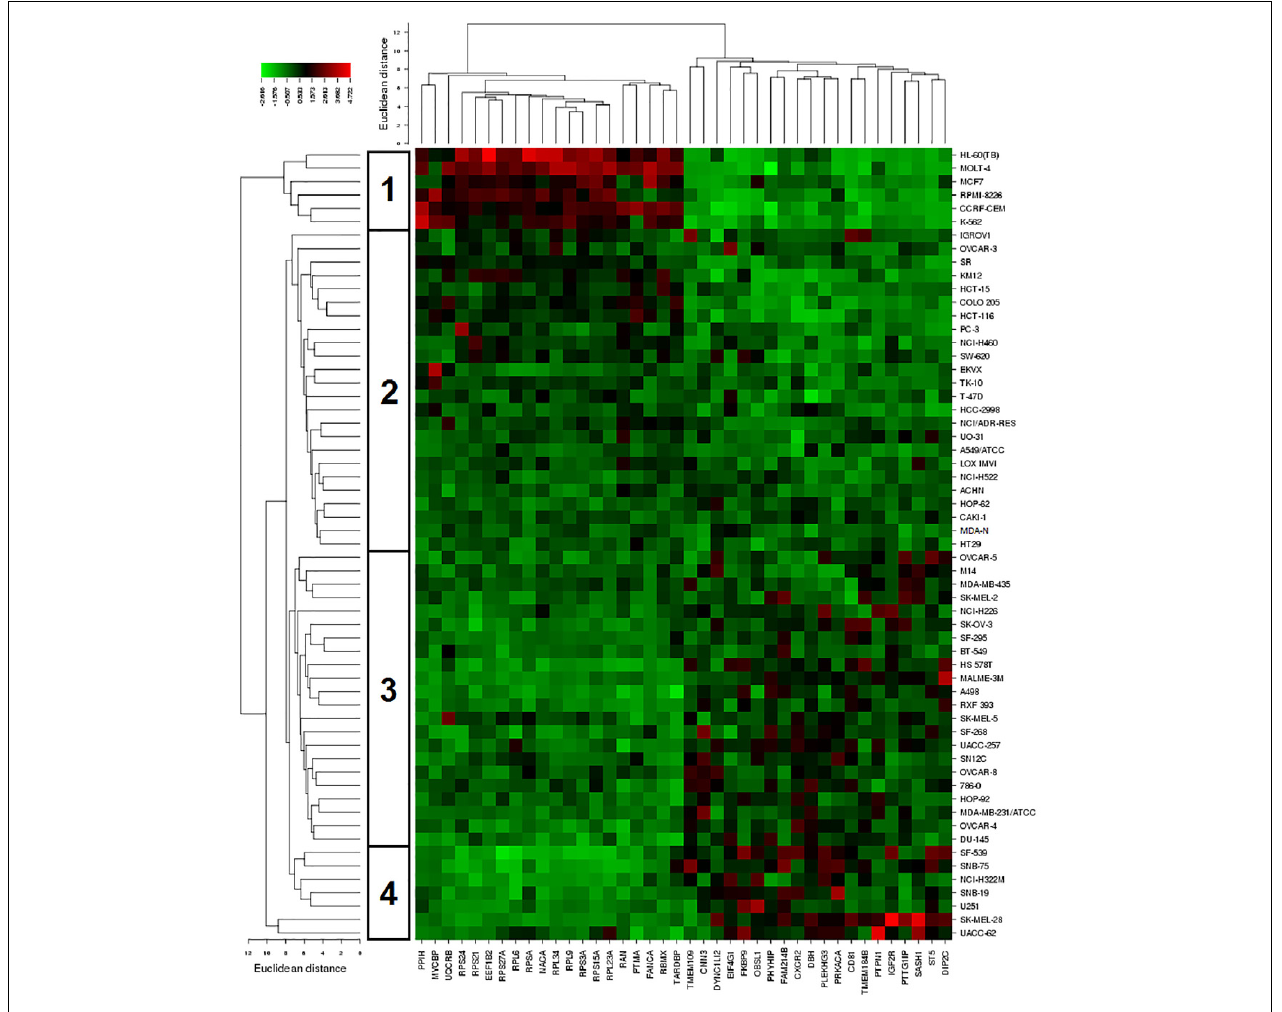
FIGURE 8 | Hierarchical cluster analysis and heat map of expression of genes involved in cellular sensitivity of the NCI cell line panel to bromocriptine.